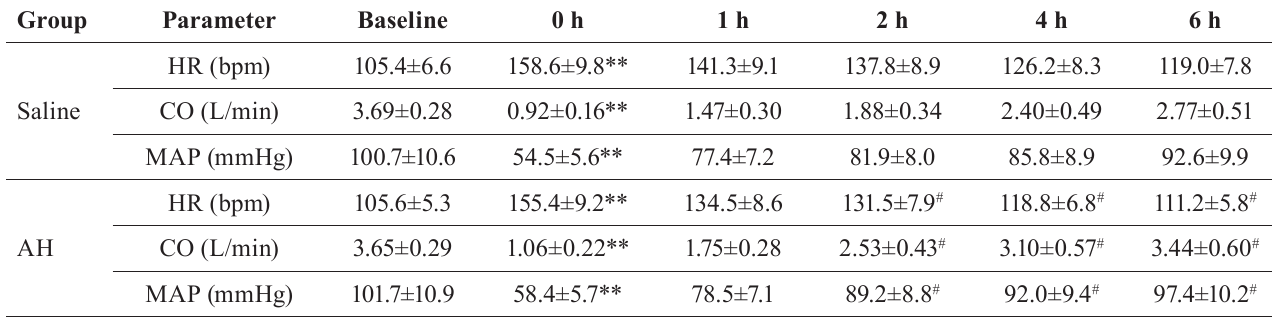
TABLE IV - The comparison of hemodynamics at different time points after ROSC Group Parameter Baseline 0 h